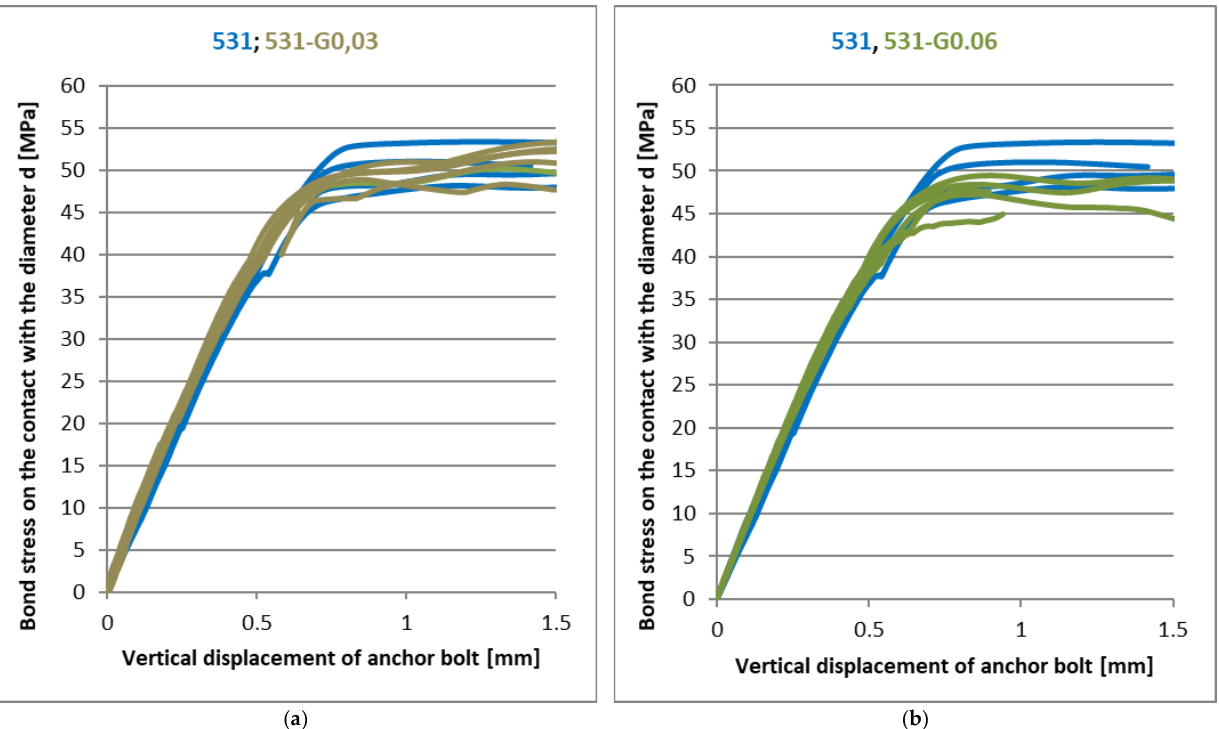
Figure 11. The effect of the graphene oxide GO21 on CHS Epoxy 531 ( a ) 0.03 phr; ( b ) 0.06 phr.